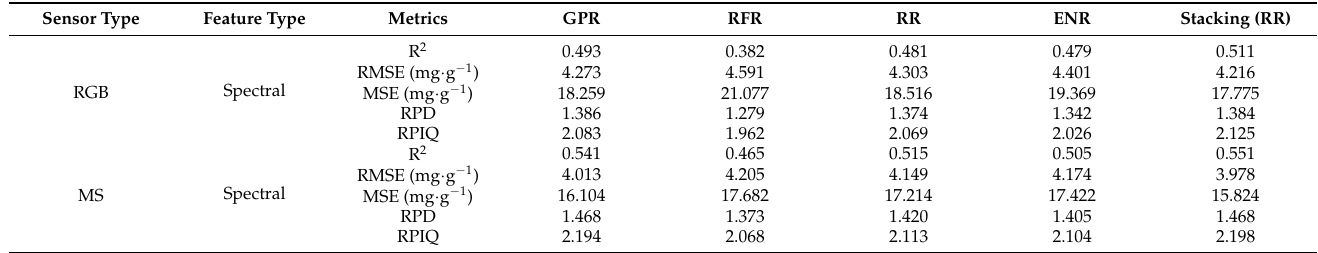
Table 5. TNC prediction accuracy based on different machine learning